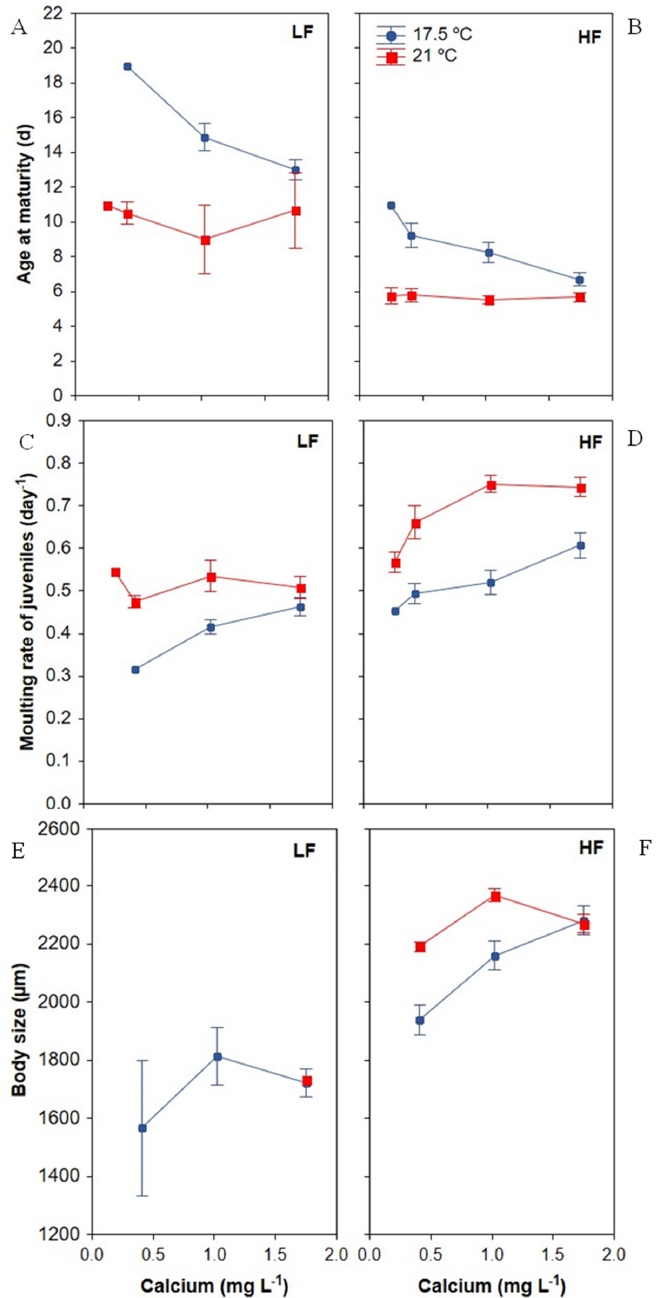
Figure 4. Effects of calcium concentration on development traits of D. pulex at two temperatures and low (LF) or high (HF) food level. Data represent mean ± SE. ( A , B ): Age of maturity. Error whiskers are not present for the 17.5 °C HF 0.25 mg Ca L − 1 treatment because all individuals reproduced at the age of 11 days ( n = 3); in the 17.5 °C LF 0.25 mg Ca L − 1 treatment, no female reached reproductive maturity; in the 17.5 °C LF 0.41 mg Ca L − 1 and 21 °C LF 0.25 mg Ca L − 1 treatments, only one female reached reproductive maturity; ( C , D ): Moulting rate of juveniles. Data for the 17.5 °C LF 0.25 mg Ca L − 1 treatment are absent because no female reached reproductive maturity; in 17.5 °C LF 0.41 mg Ca L − 1 and 21 °C LF 0.25 mg Ca L − 1 treatments only one female reached reproductive maturity; ( E , F ): Body size. Some data are not present because no animal survived on day 19.